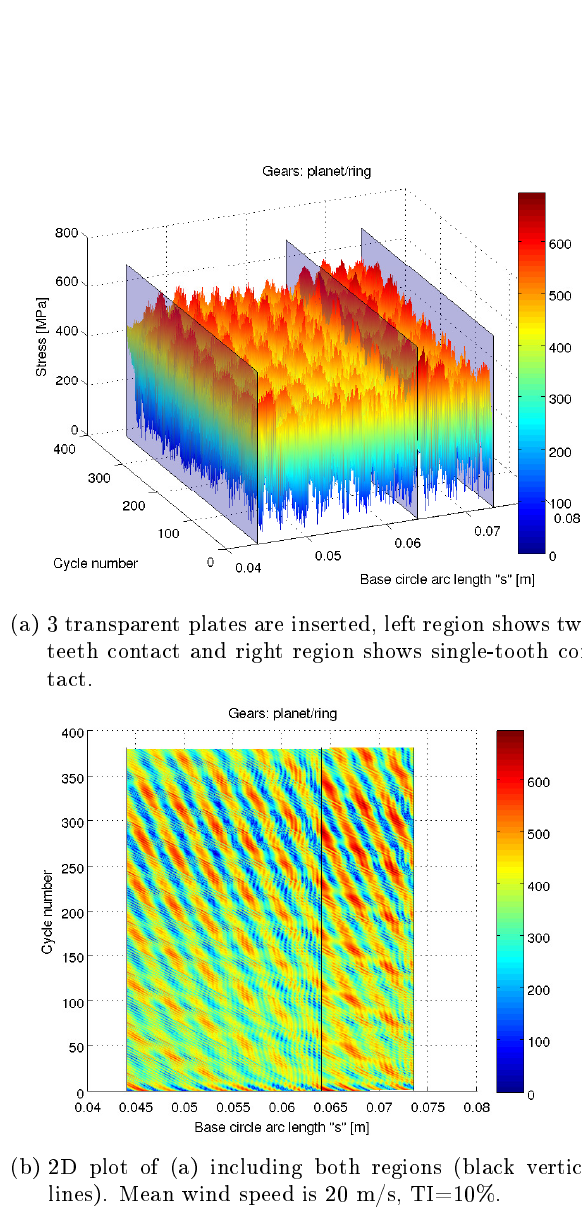
Figure 12: Estimated von Mises stress for 30 second simulation time, as a function of base circle arc length (cid:16)s(cid:17). For this to be plotted prop- erly, interpolated von Mises stress values are